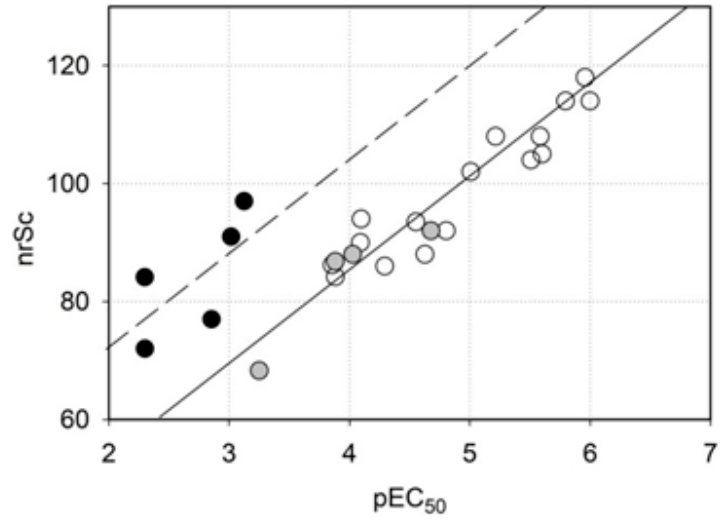
Figure 5. Inhibitory activity, as predicted by the negative rerank score (nrSc) provided by Molegro Virtual Docker (MVD), plotted against measured inhibitory activity (expressed as pEC 50 , the negative decadic logarithm of EC 50 ). Open circles—amines and amides containing a thiazole ring; gray circles—4-alkyl resorcinols; black circles—compounds with other rings replacing the thiazole moiety.